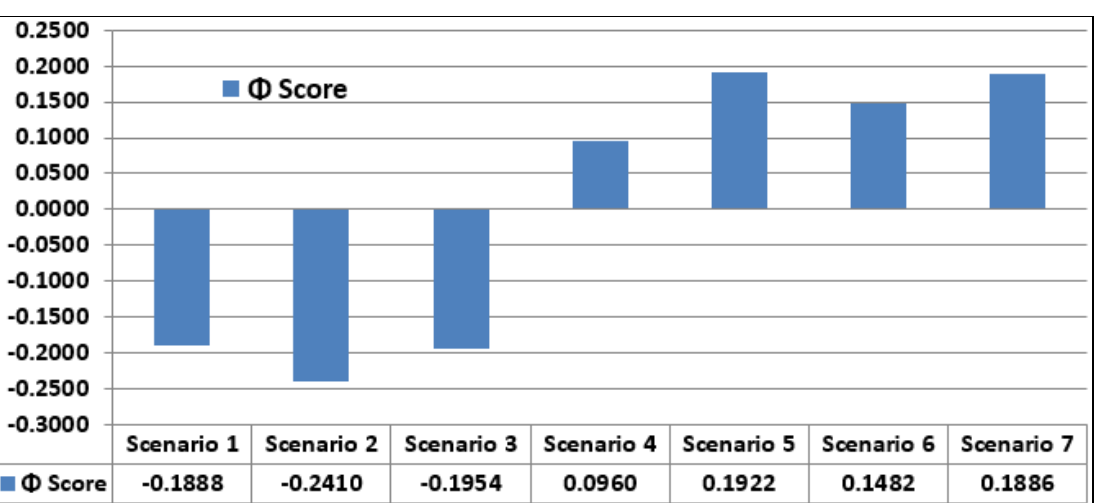
Figure 2 . Usual criterion (Type I) preference function. Figure 2. Usual criterion (Type I) preference function.